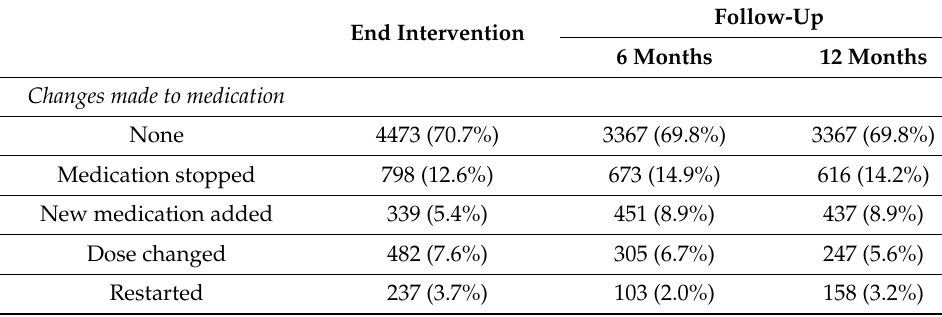
Table 6. Analysis of secondary outcomes medication